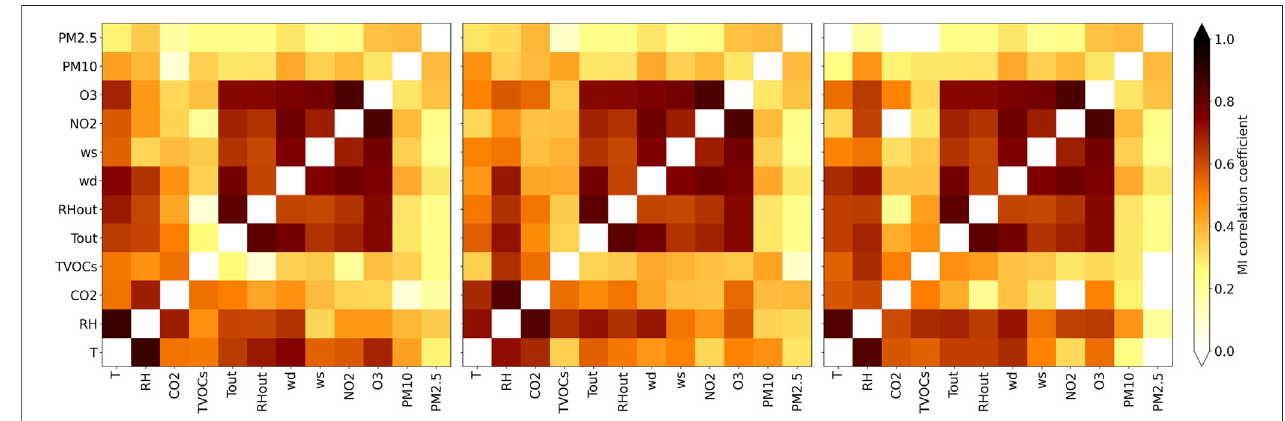
FIGURE 8 | Inter-parameter correlation coef fi cients for MyAir #59, #51, and #25 (shown respectively from left) where maximum MI correlations were